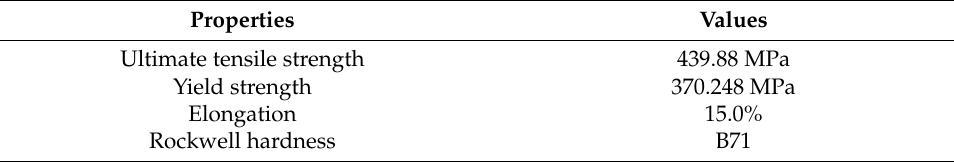
Table 4. Properties of mild steel.